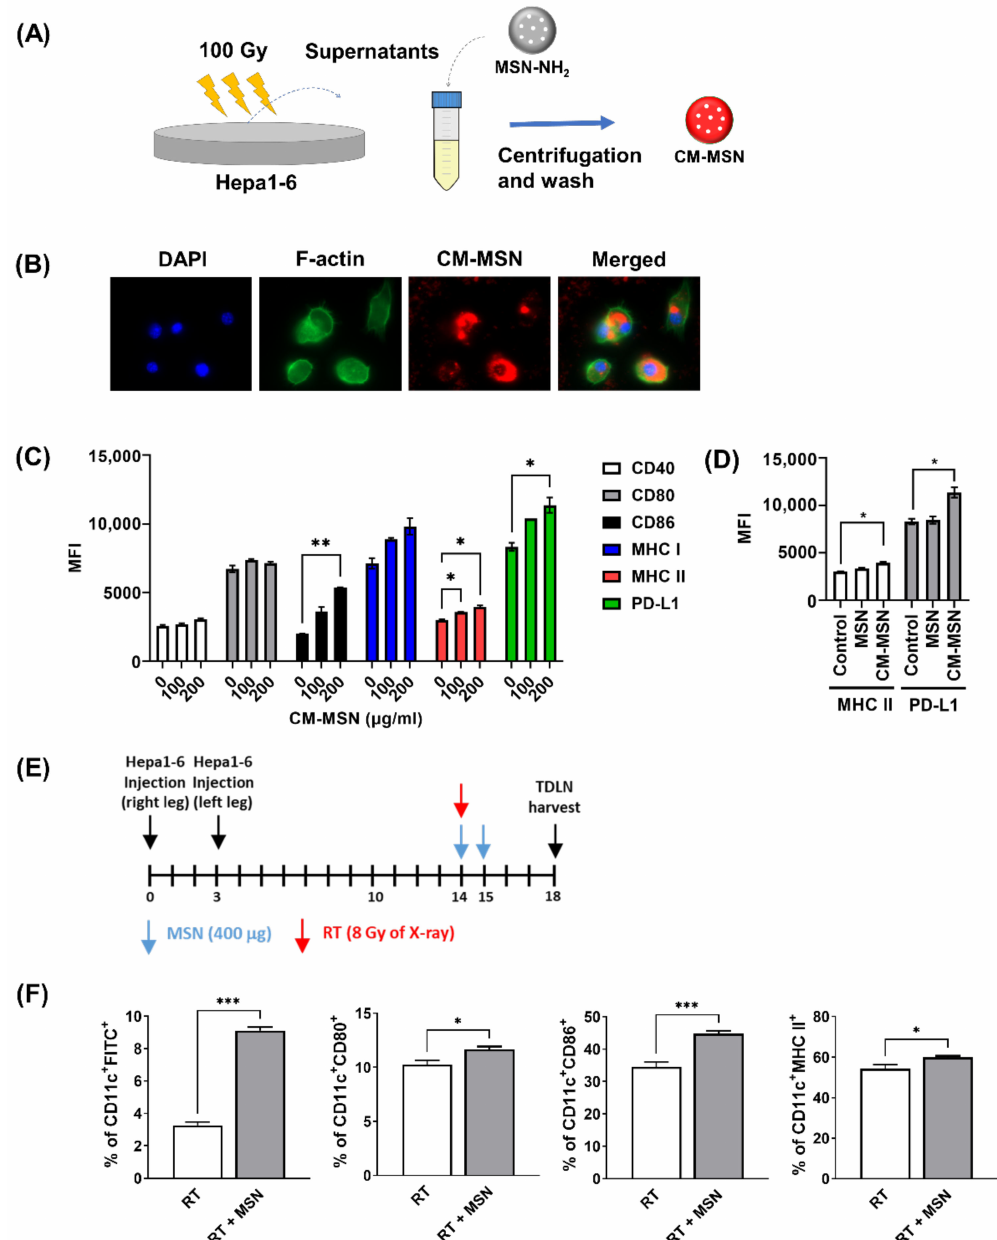
Figure 4. MSNs pre-incubated with the irradiated cell conditioned medium activates dendritic cells in vitro and in vivo. ( A ) Schematic diagram for the preparation of conditioned medium-incubated MSNs (CM-MSNs). ( B ) Uptake of CM-MSNs into JAWS II cells. Representative images of CM-MSNs labeled with rhodamine. ( C ) CM-MSNs activated JAWS II, an immortalized immature dendritic cell line. ( D ) MSNs without preconditioning did not activate JAWS II cells. ( E ) Schedule of timing of harvesting tumor-draining lymph nodes. ( F ) Flow cytometry data showing the MSN-increased population of activated DCs in TDLNs. * p < 0.05; ** p < 0.01; *** p <